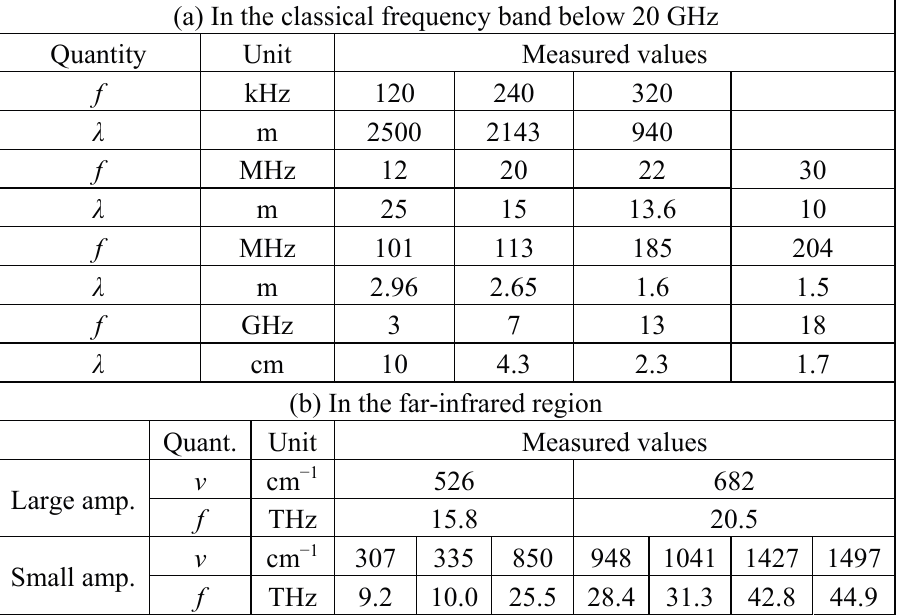
Table 1. Spectral resonant components of microtubule oscillations. ( f